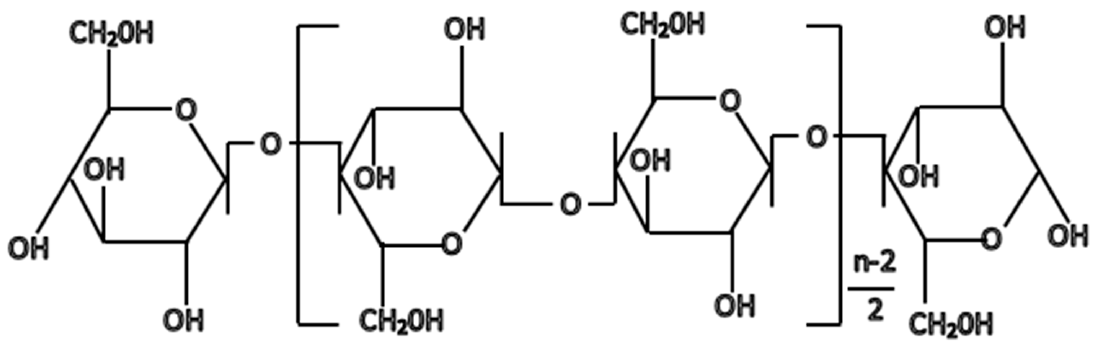
Figure 1. Cellulose molecular chemical structure.